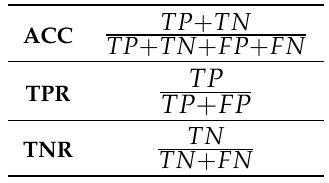
Table 2. Confusion Matrix Parameters.